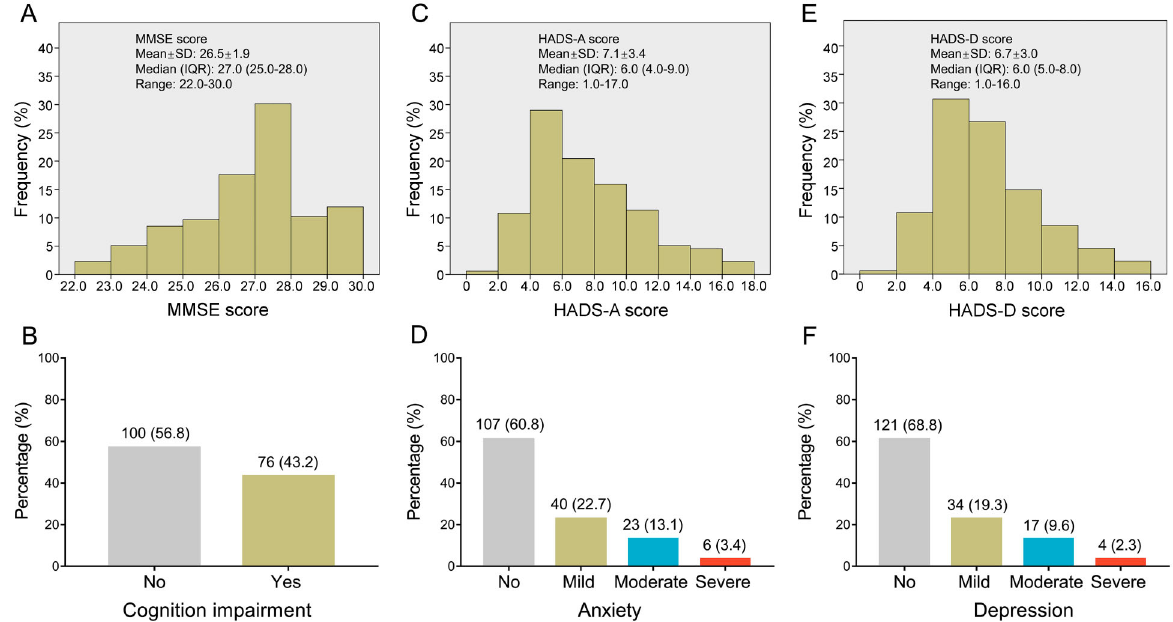
Figure 1. Overall cognition impairment, anxiety, and depression in acute ischemic stroke patients. Distribution of MMSE score ( A ), HADS-A score ( C ), and HADS-D score ( E ). Number (percentage) of cognition impairment ( B ), anxiety ( D ), and depression ( F ) grade. MMSE: Mini-Mental State Examination; HADS-A: Hospital Anxiety and Depression Scale for anxiety; HADS-D: Hospital Anxiety and Depression Scale for depression; SD: standard deviation; IQR: interquartile